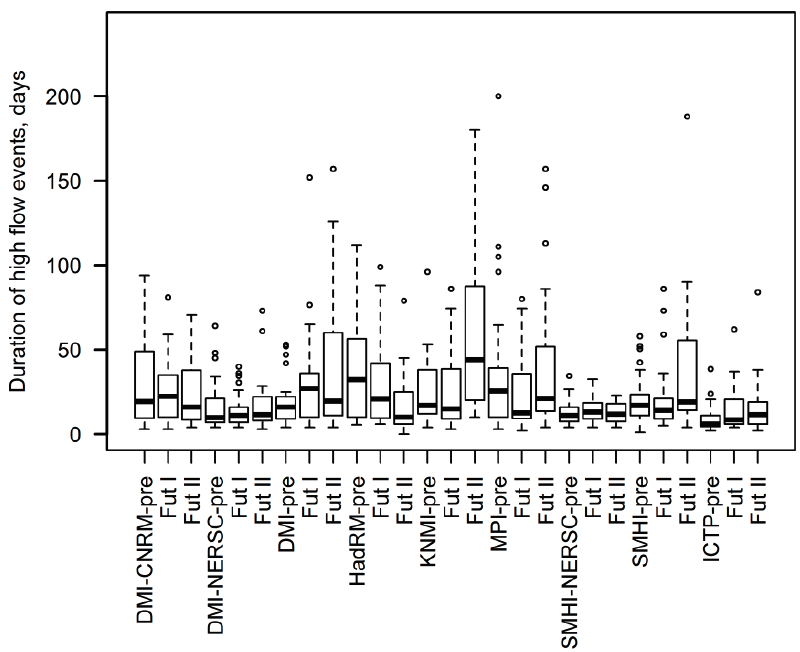
Figure 7. Duration of high flow event in days for reference and two future periods for all nine future projections, respectively.